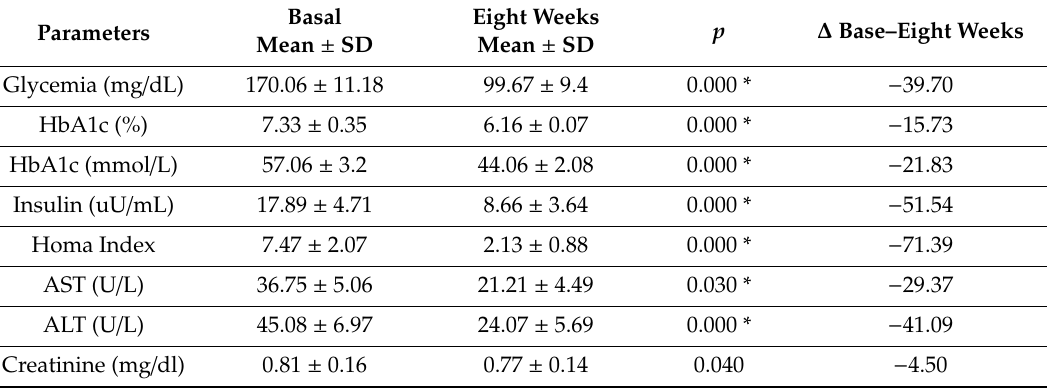
Table 3. Parameter changes during dietetic treatment (baseline, 8